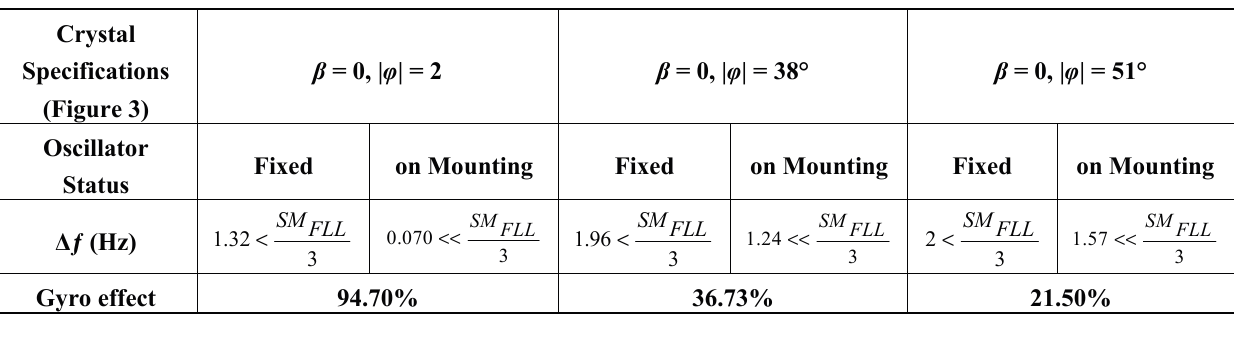
Figure 13. Maximum disturbances caused by sinusoidal vibration. ( a ) Frequency jitter of a fixed oscillator; ( b ) Frequency jitter of the gyroscopic mounting; ( c ) Phase jitter of a fixed oscillator; ( d ) Phase jitter of the gyroscopic mounting. Table 2. Gyroscopic mounting effect on sinusoidal vibration-induced disturbances on FLL at critical